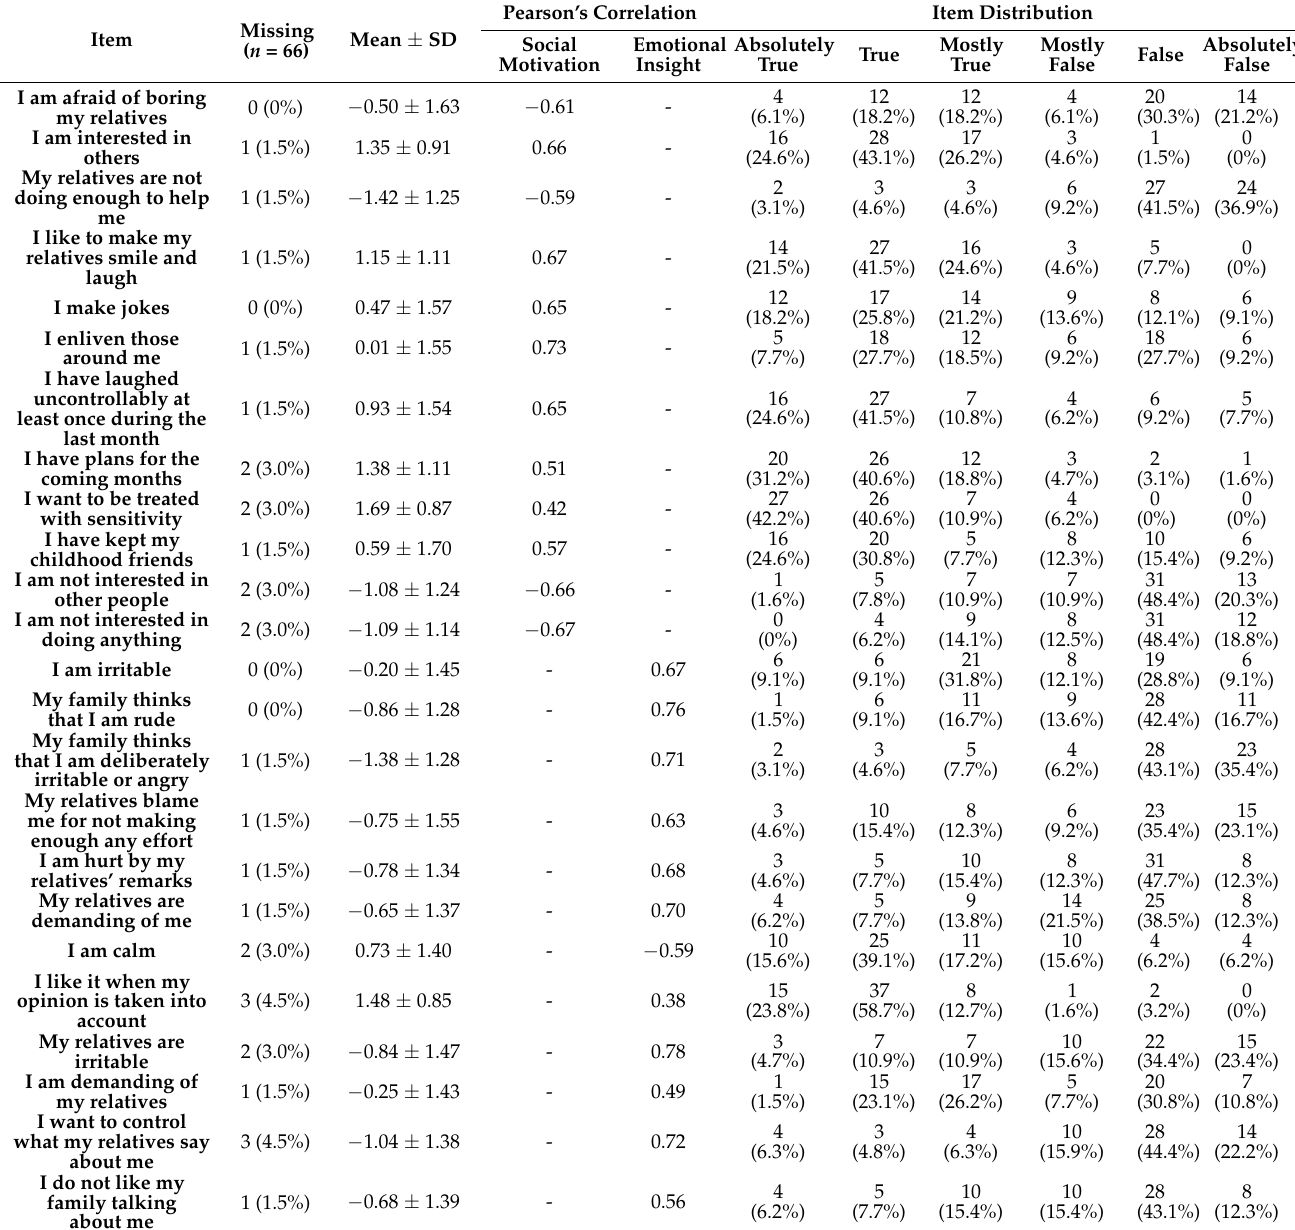
Abbreviations: SD = standard